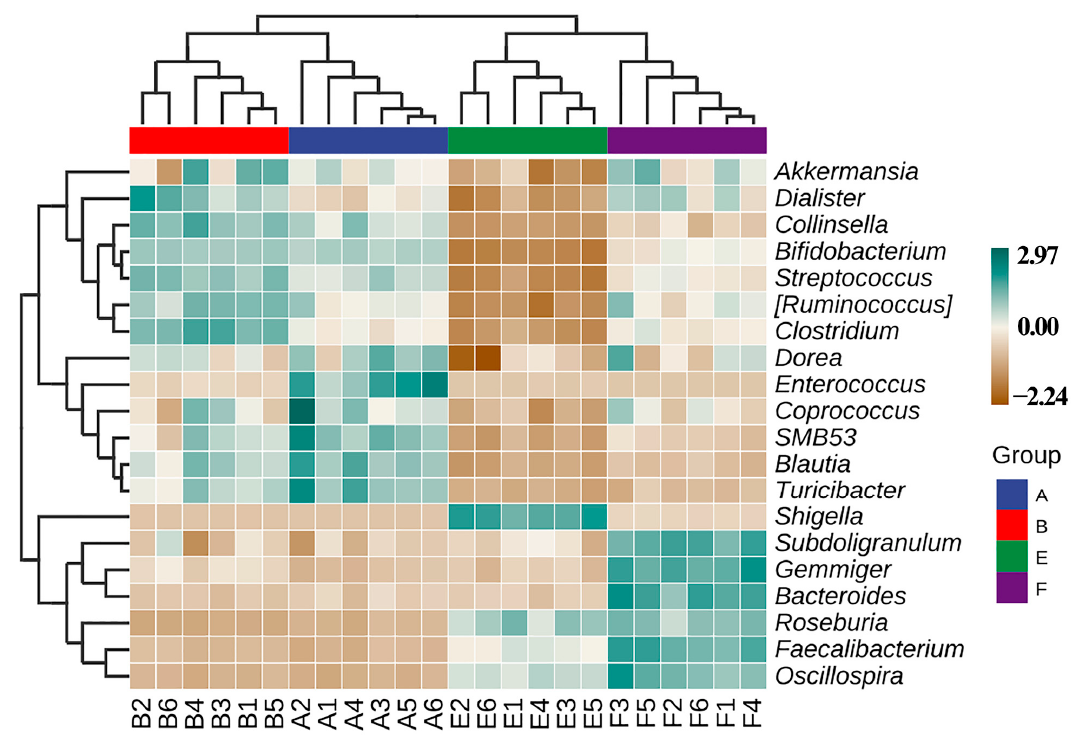
Figure 9. Effect of ZnONP on composition and distribution of the main 20 genus among samples. A: healthy children; B: healthy children + ZnONP; E: ASD children; F: ASD children + ZnONP.